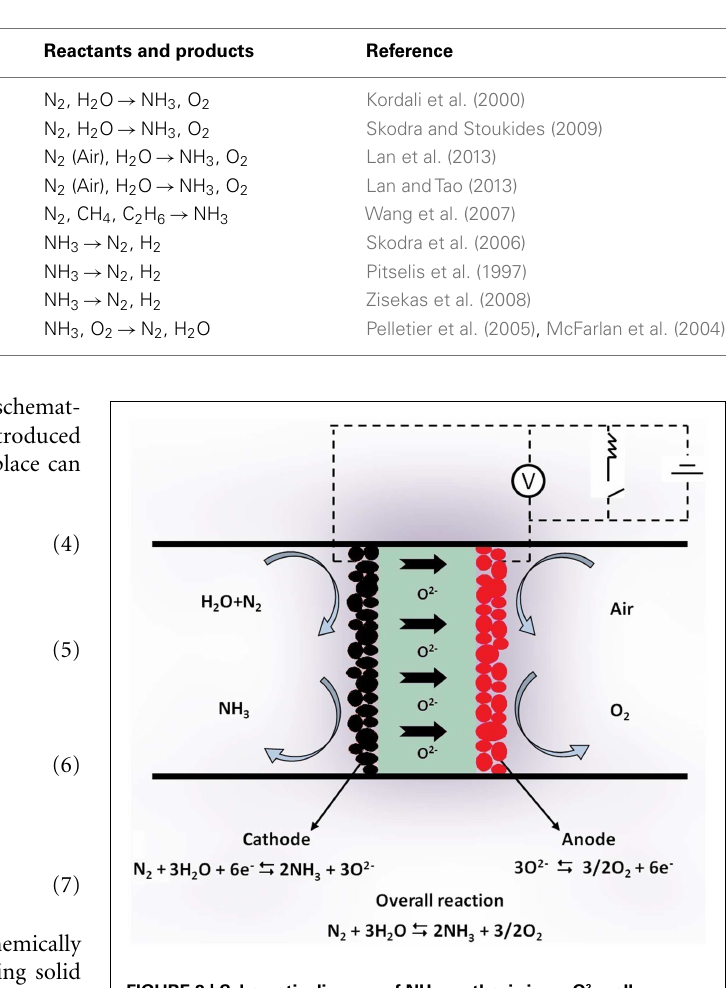
FIGURE 2 | Schematic diagram of NH 3 synthesis in an O 2 − cell